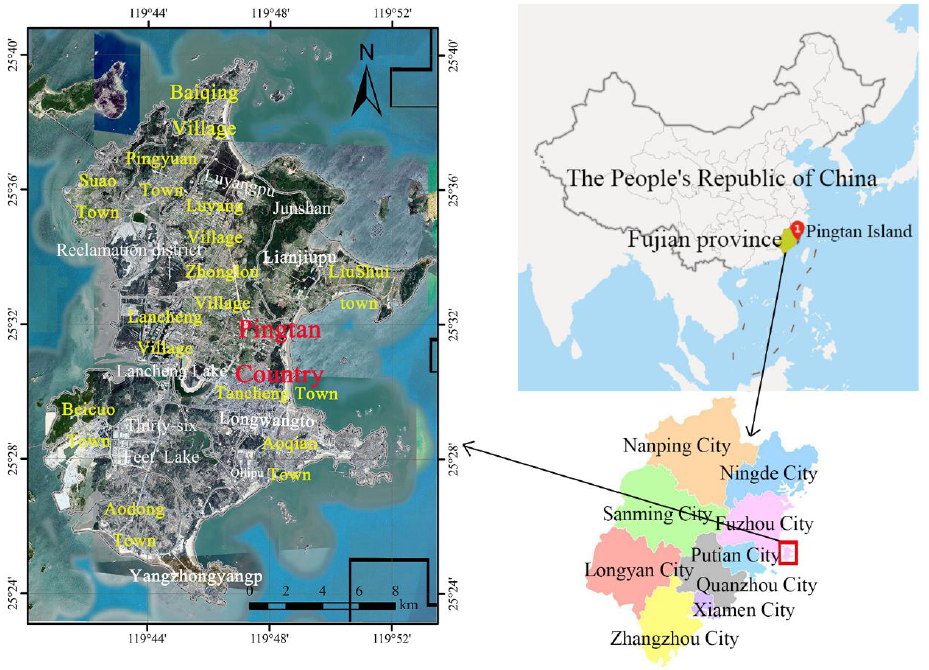
Figure 1. Pingtan Island Satellite map.